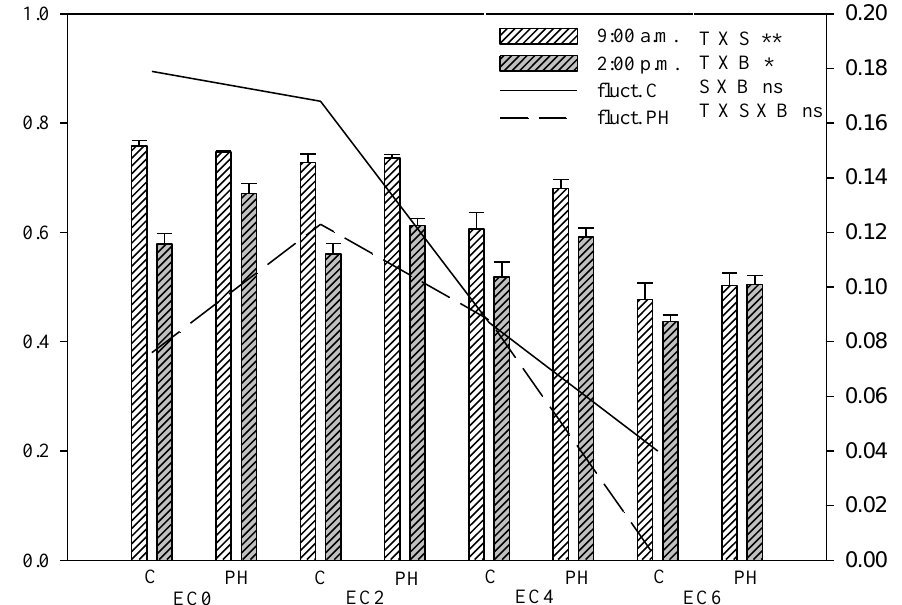
Figure 7. Φ PSII (effective quantum yield efficiency of PSII) of hemp leaves in the DAS as affected by saline water irrigation (EC0 = non-saline water; EC2 = water at 2.0 dS m − 1 ; EC4 = water at 4.0 dS m − 1 ; EC6 = water at 6.0 dS m − 1 ) and biostimulant application (treated with a commercial legume-derived protein hydrolysate = PH and non-treated = C) recorded at 9:00 a.m. and at 2:00 p.m. Bars are means ± s.e. ( n = 10). The significance of the interactions between experimental factors (T time of measurement, S salinity level, B biostimulant application) according to Duncan’s test is reported (* p ≤ 0.05, ** p ≤ 0.01, ns non-significant); pairwise comparisons with the Student’s t-test are reported in Table S1. The lines show the fluctuation between the 9:00 a.m. and 2.00 p.m. of Φ PSII (values on the right axis) per each salinity